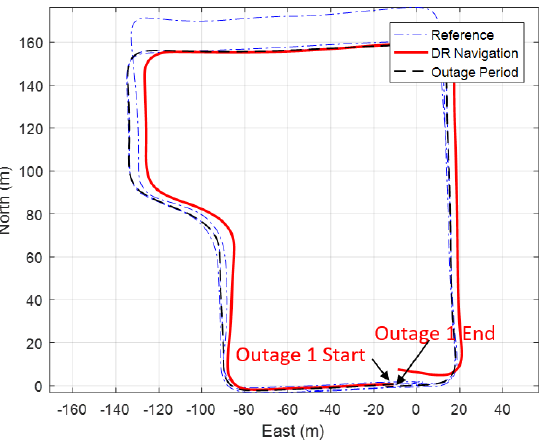
Figure 14. DR trajectory based on CPD sensors and onboard gyroscope for 90 seconds GNSS signal outage